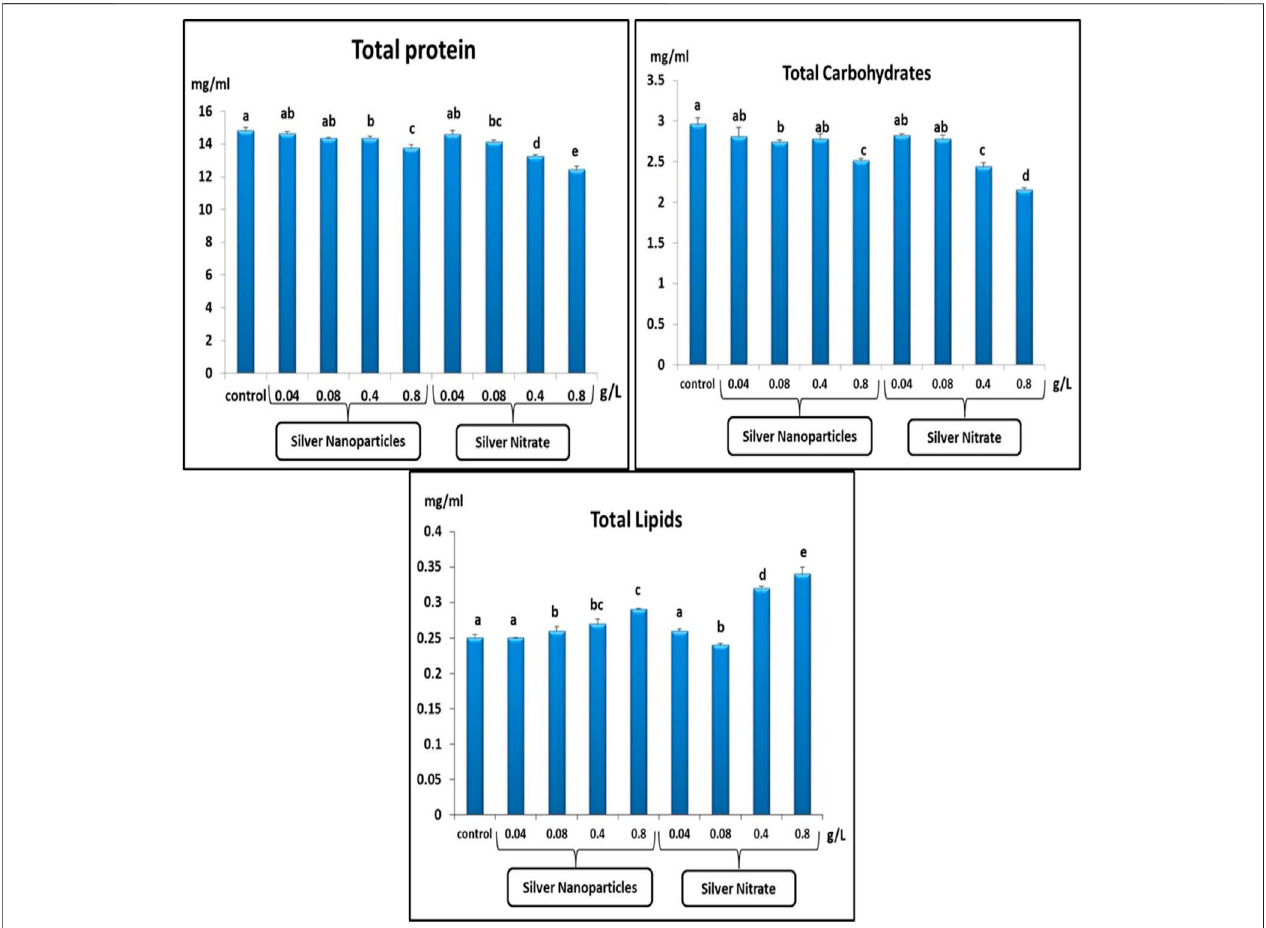
FIGURE 3 | Total protein (mg/ml), total carbohydrates (mg/ml) and total lipids (mg/ml) in slugs ( Lehmannia nyctelia ) after silver nanoparticles and silver nitrite exposure for 15 days. Bars represent the mean ± SE of the control and experimental groups. Different letters indicate signi fi cant differences amongst treatments ( p <